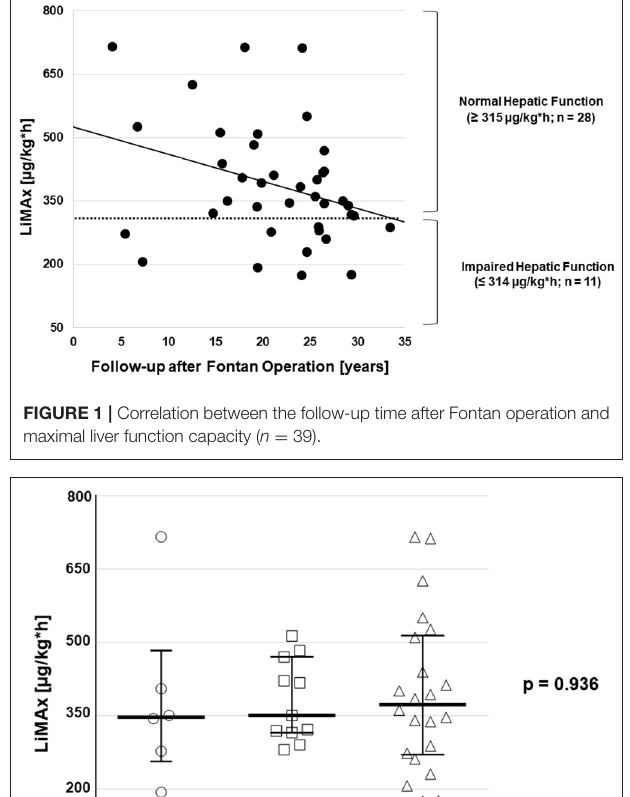
TABLE 2 | Hepatic assessment.